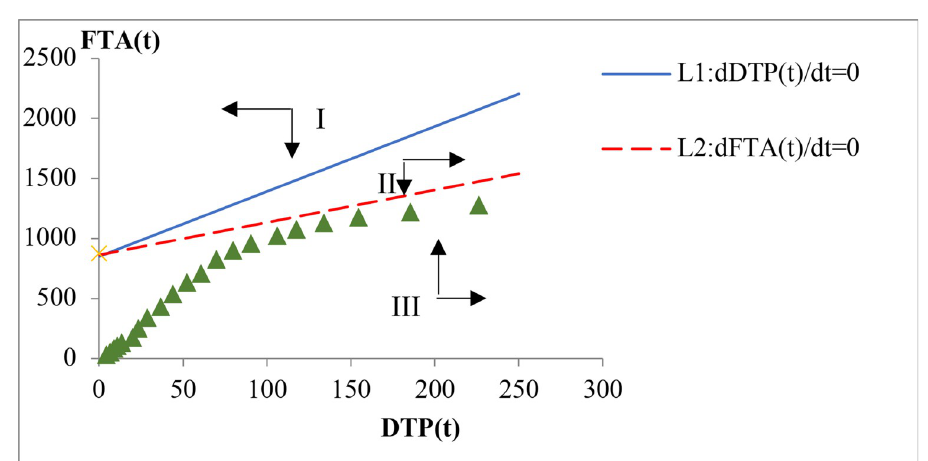
Fig 5. Evolutionary trend of DTP and FTA.